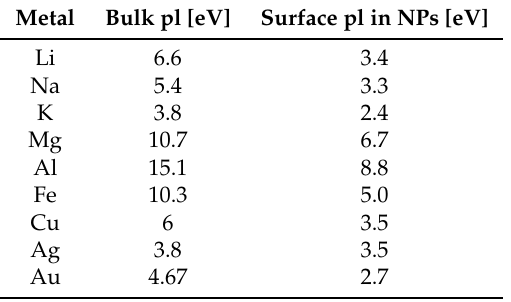
Table 1. Plasmon energies measured in metals.